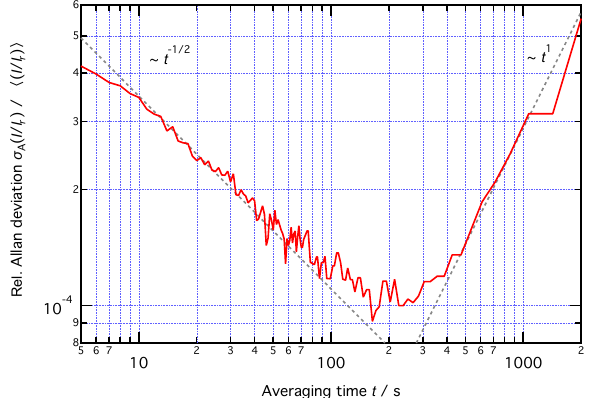
Figure 3. The stability of the photometer has been checked each measurement day after 2h of laser warm up and before the mea- surements were performed. The measurement showing the lowest level of stability is shown. Data obtained on other days fall below the above curve, which is characterised by a white noise dependence ( ∼ t − 1 / 2 ) for about 100 to 180s before a linear drift component be- comes